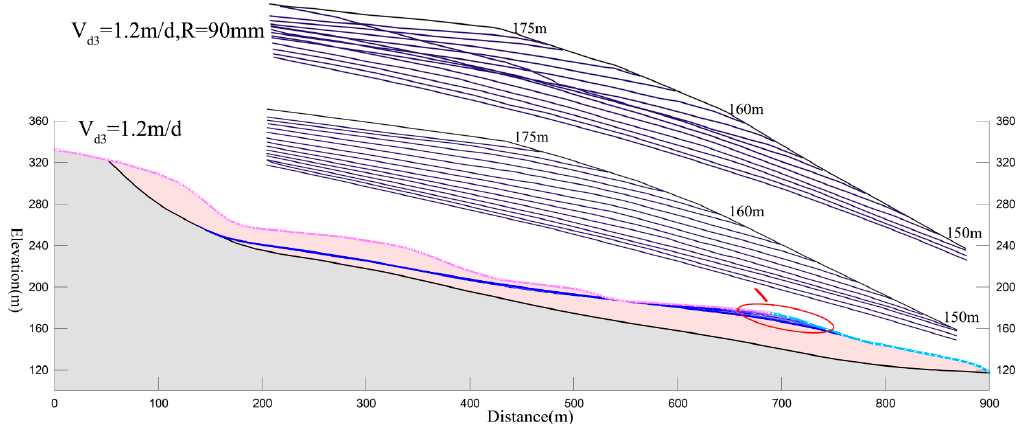
Figure 8. Transient changes under operating condition 3.